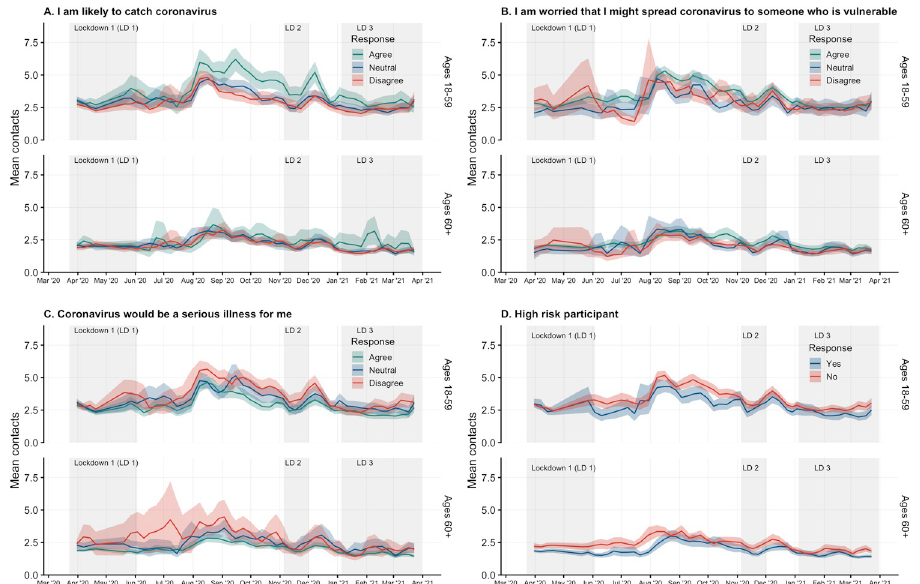
Fig 3. Mean contacts by risk perception or risk category by adult age groups of 18 to 59 and 60 or more years with 95% CI of bootstrapped mean weighted by age, gender, and weekday. Participants answered a series of questions about their risk perception with Likert scale response options. Answers of “Strongly agree” and “Somewhat agree” were combined into a category of “Agree, as were answers of “Strongly disagree” and “Somewhat disagree” to “Disagree.” (A) Answers to the statement “I am likely to catch coronavirus.” (B) Answers to the statement “I am worried I might spread coronavirus to someone who is vulnerable.” (C) Answers to the statement “Coronavirus would be a serious illness for me.” (D) Participant reported they were an individual at high risk for complications as defined in the questionnaire. CI, confidence interval; LD,